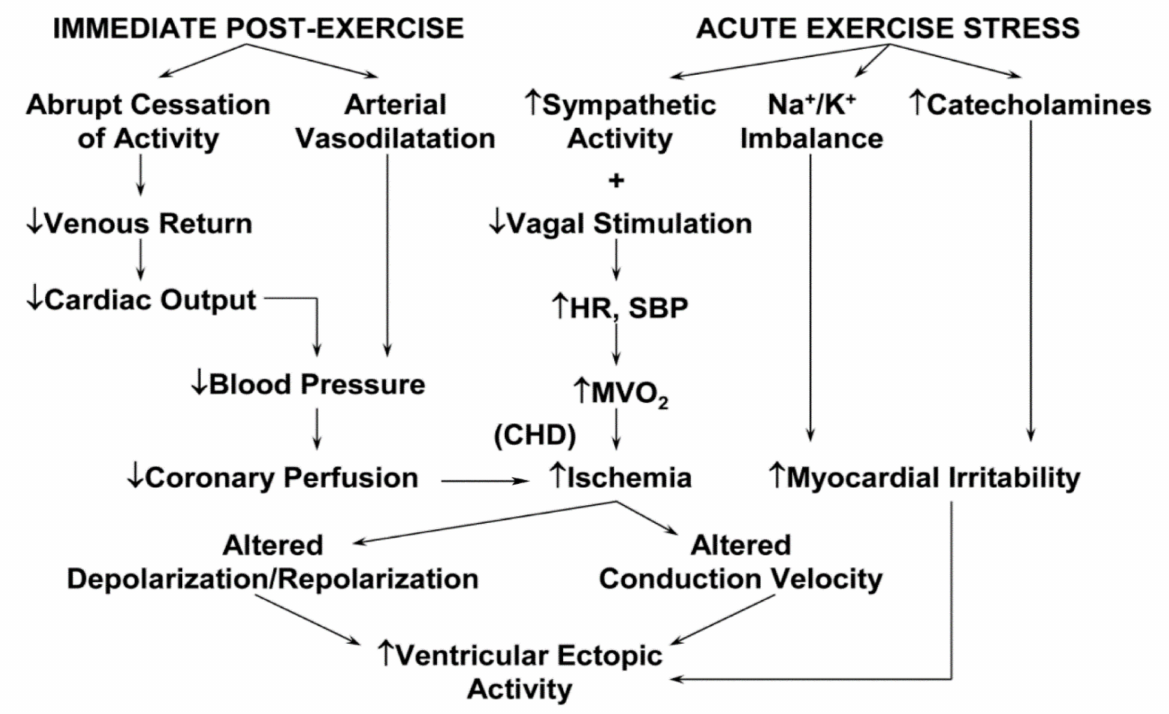
Figure 3. Physiologic alterations accompanying acute exercise training and recovery and their possible sequelae. CHD, coronary heart disease; HR, heart rate; SBP, systolic blood pressure; MVO 2 , myocardial oxygen